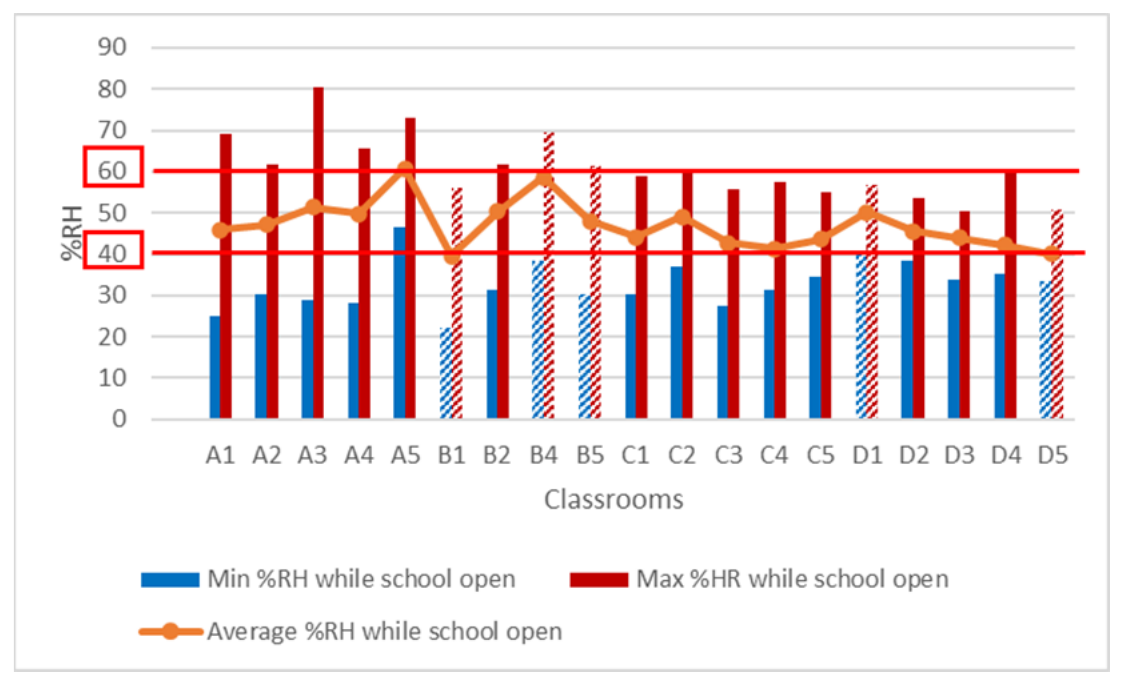
Figure 21. Indoor relative humidity in the classrooms during school hours, with classrooms B1, B4, B5, D1 and D5 having mechanical ventilation.